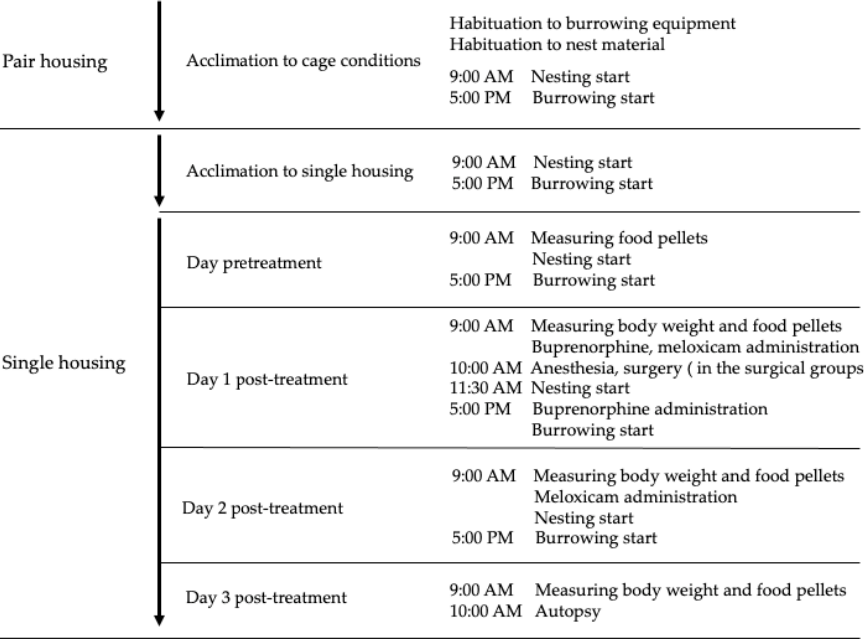
Figure 1. Outline of the experimental schedule.